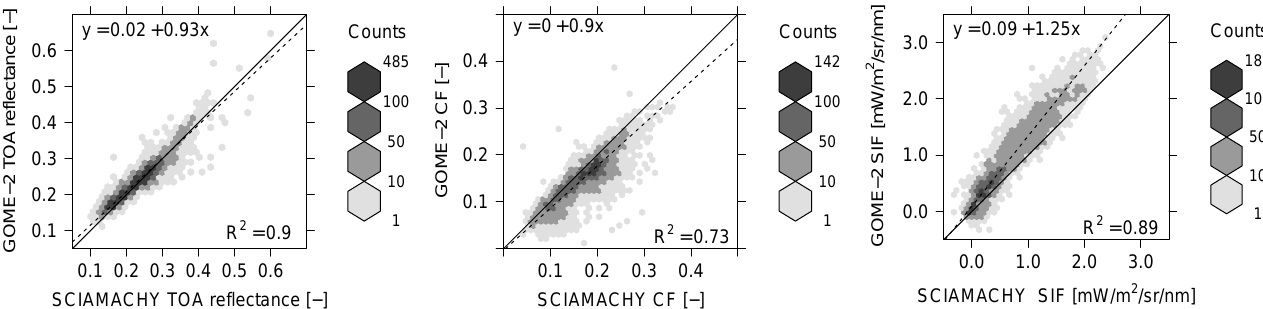
Figure 11. GOME-2 versus SCIAMACHY data of TOA reflectance at 720nm, FRESCO (Wang et al., 2008) cloud fractions (CF) and SIF. Averages from February 2007 to December 2011 (rastered on 1 . 5 ◦ × 1 . 5 ◦ grid) with a cloud fraction lower than 0.5 have been used. The linear fits are depicted as dotted lines.